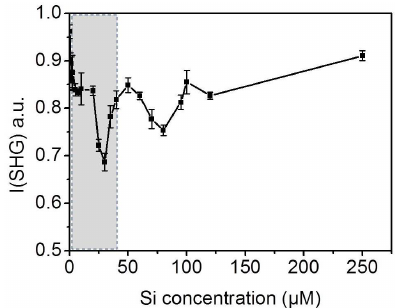
Figure 6. SHG intensity as a function of silica ion concentration at pH 3 at 20 ◦ C. The error bars represent the standard deviation from the corresponding average